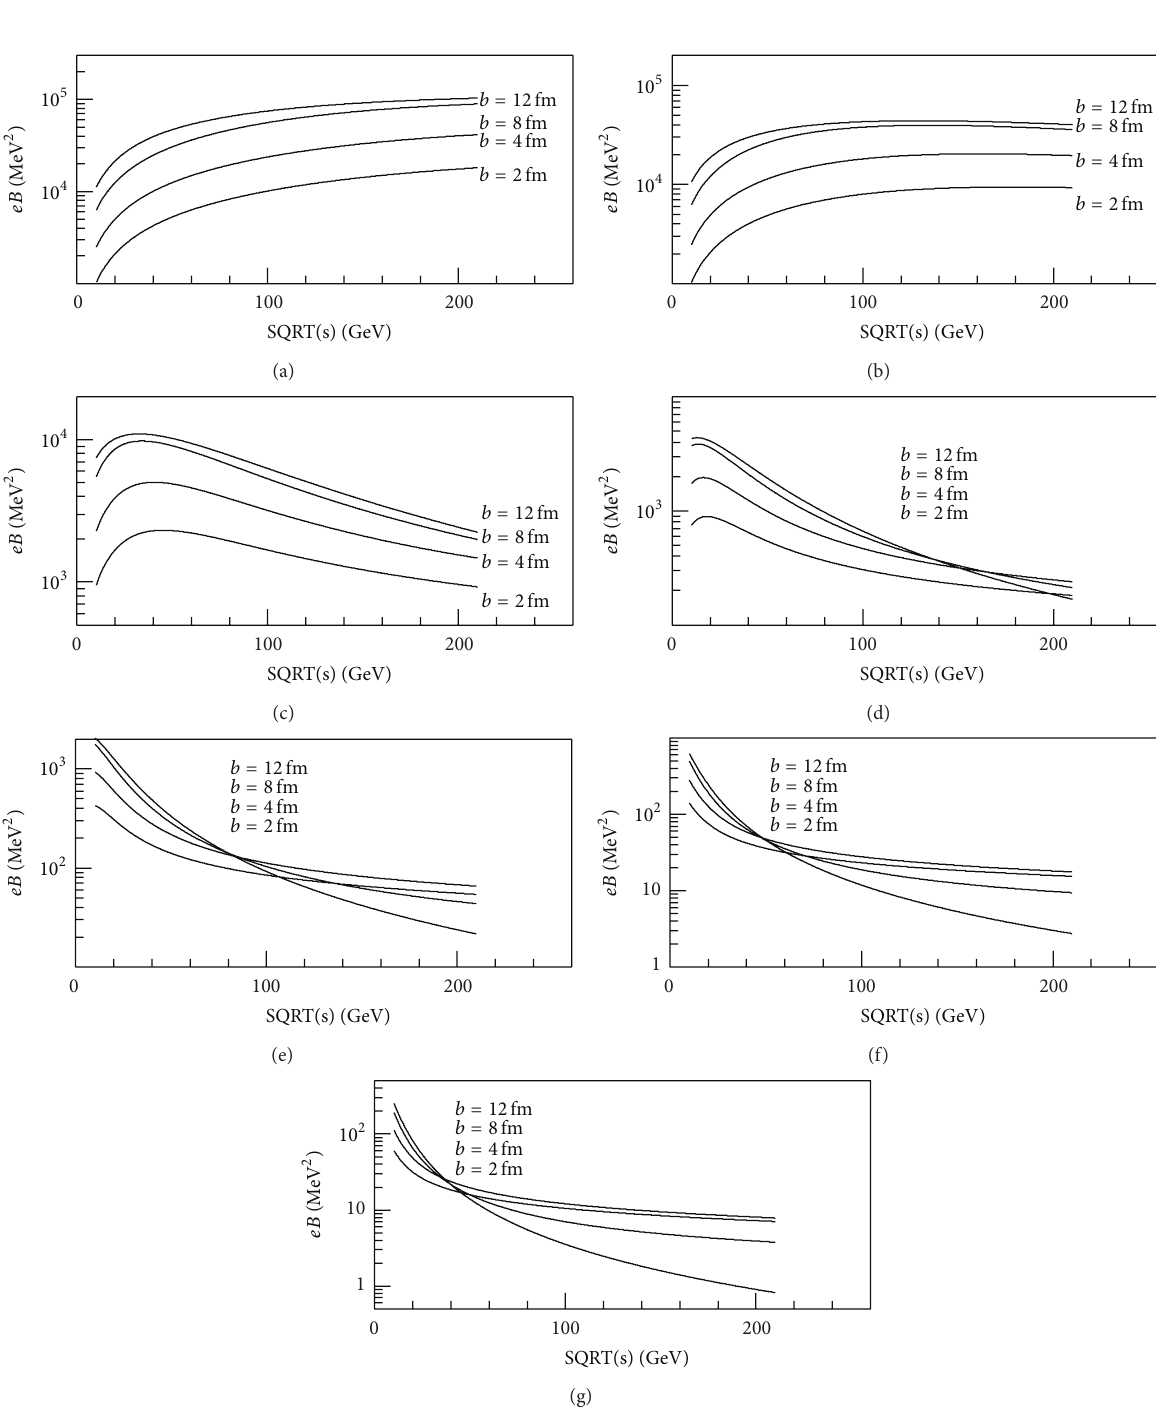
Figure 4: The dependencies of the magnetic field on collision energies of central mass system less than 200 GeV at RHIC energy region at different impact parameters for Au-Au collisions at different proper times for 𝜏 = 0.02 fm (a), 𝜏 = 0.05 fm (b), 𝜏 = 0.2 fm (c), 𝜏 = 0.5 fm (d), 𝜏 = 1.0 fm (e), 𝜏 = 2.0 fm (f), and 𝜏 = 3.0 fm (g),